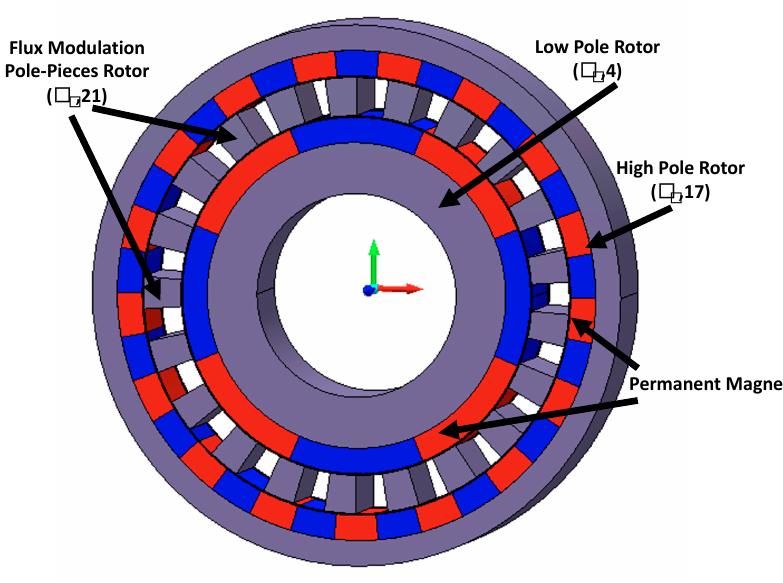
Figure 2. Surface mounted flux modulation-coaxial MG (FM-CMG).